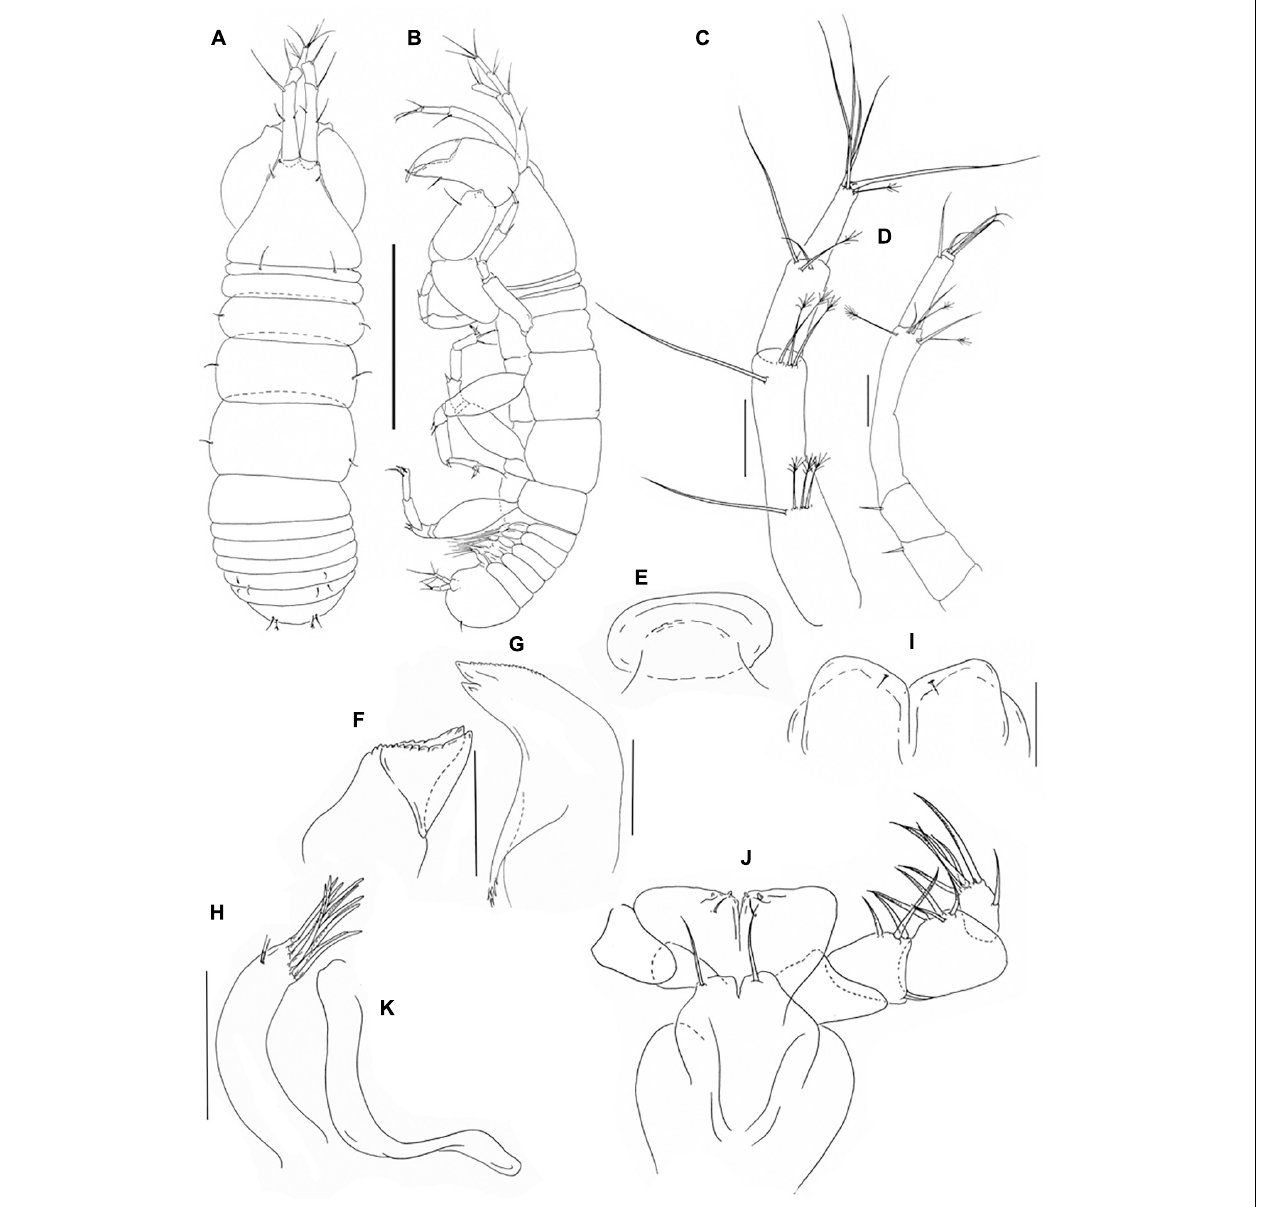
FIGURE 10 | Pseudotanais shirazi sp. nov; neuter (J59677), (A) , dorsal; (B) , lateral; (C) , antennule; (D) , antenna; (E) , labrum; (F) , left mandible; (G) , right mandible; (H) , maxillule; endite; (I) , labium; (J) , maxilliped; (K) , epignath. Scale lines (A,B) = 1 mm, (C–J) = 0.1 mm.